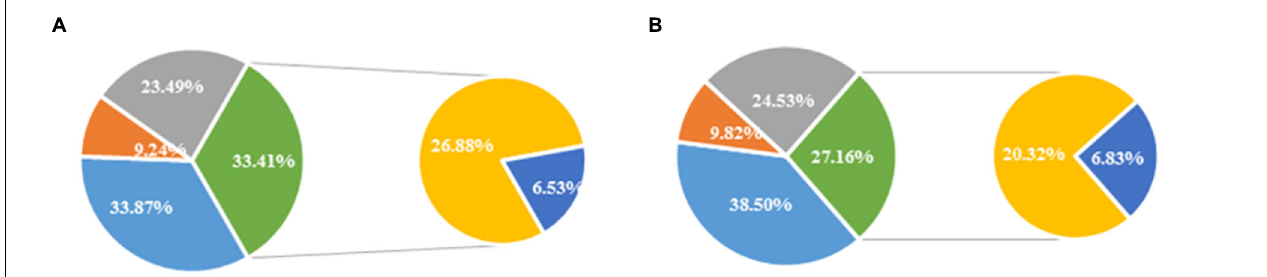
FIGURE 4 | The fatty acid content of blueberry fruit at the day 4 of shelf life at room temperature after 30 days refrigeration in control (A) and intermittent warming (B) . Mean ± SE of three replicate experiments are shown.